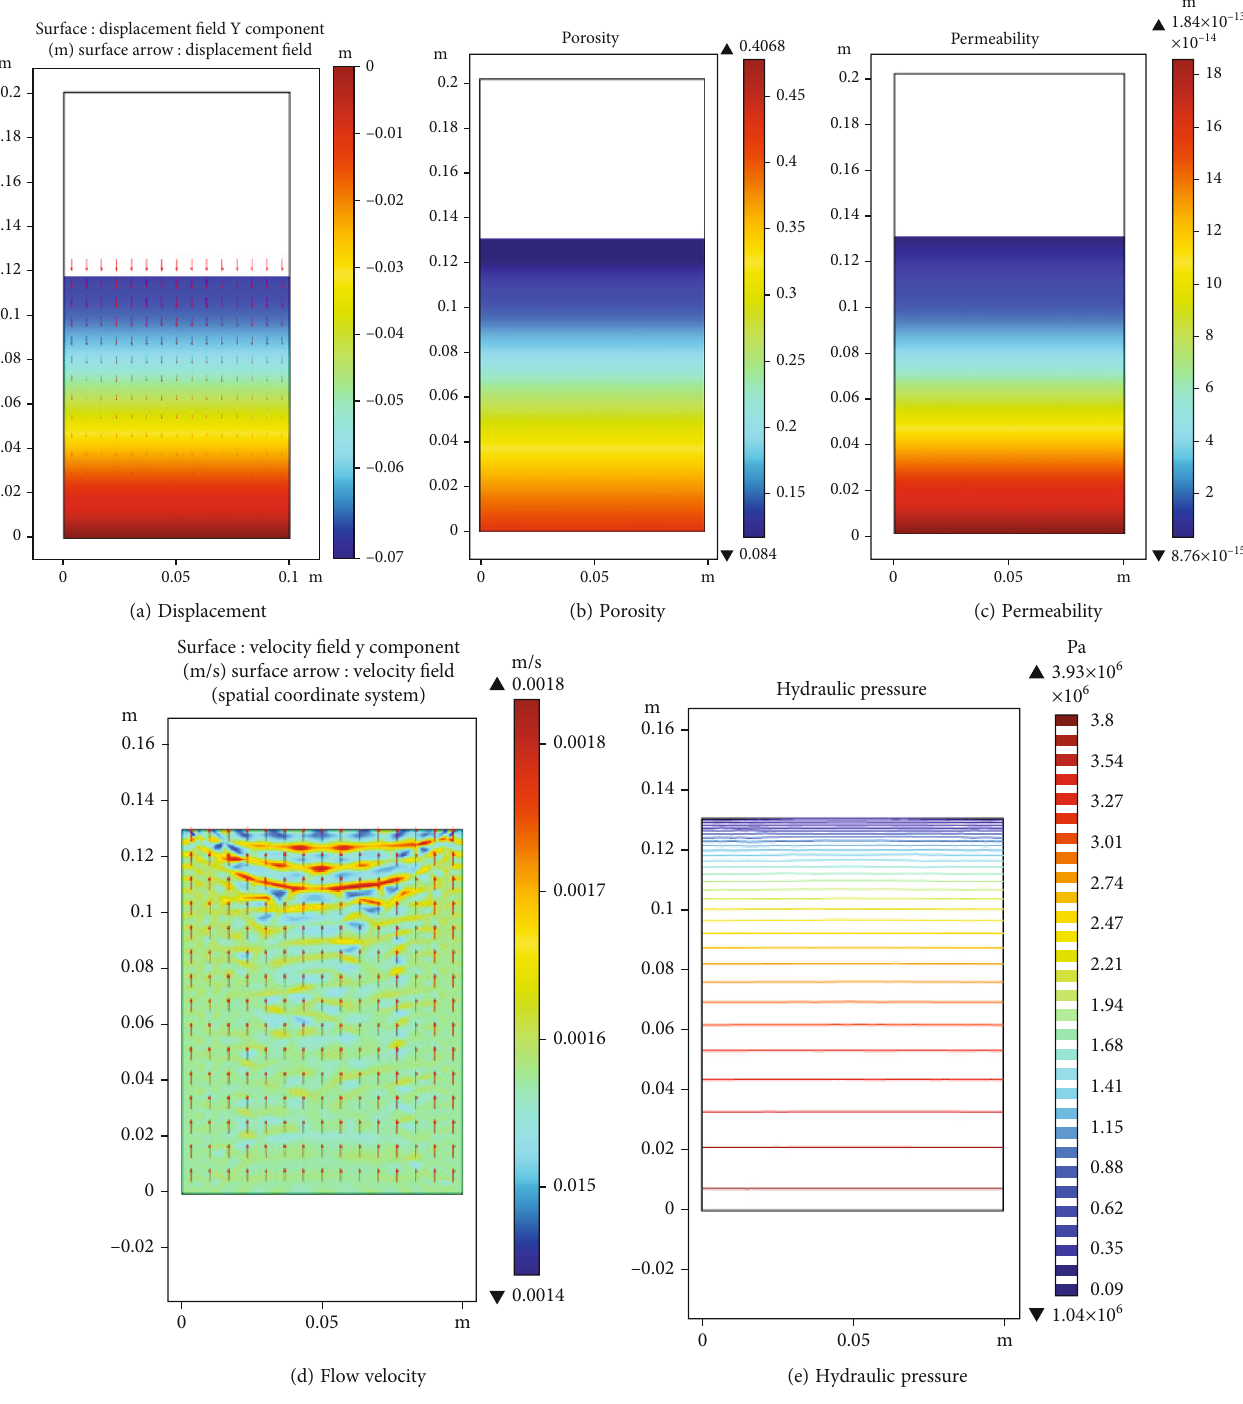
Figure 12: Seepage rules in the gangues with a size range of 5 ~